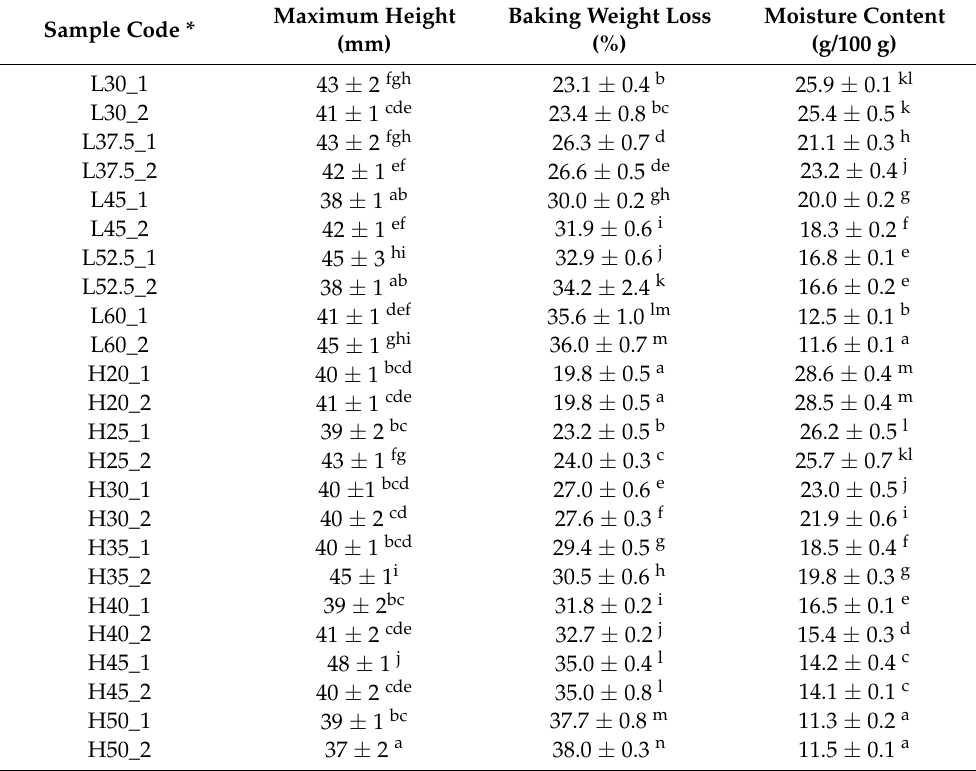
Table 2. Height, baking weight loss and moisture content of bread samples (average value ± standard deviation for each replicated